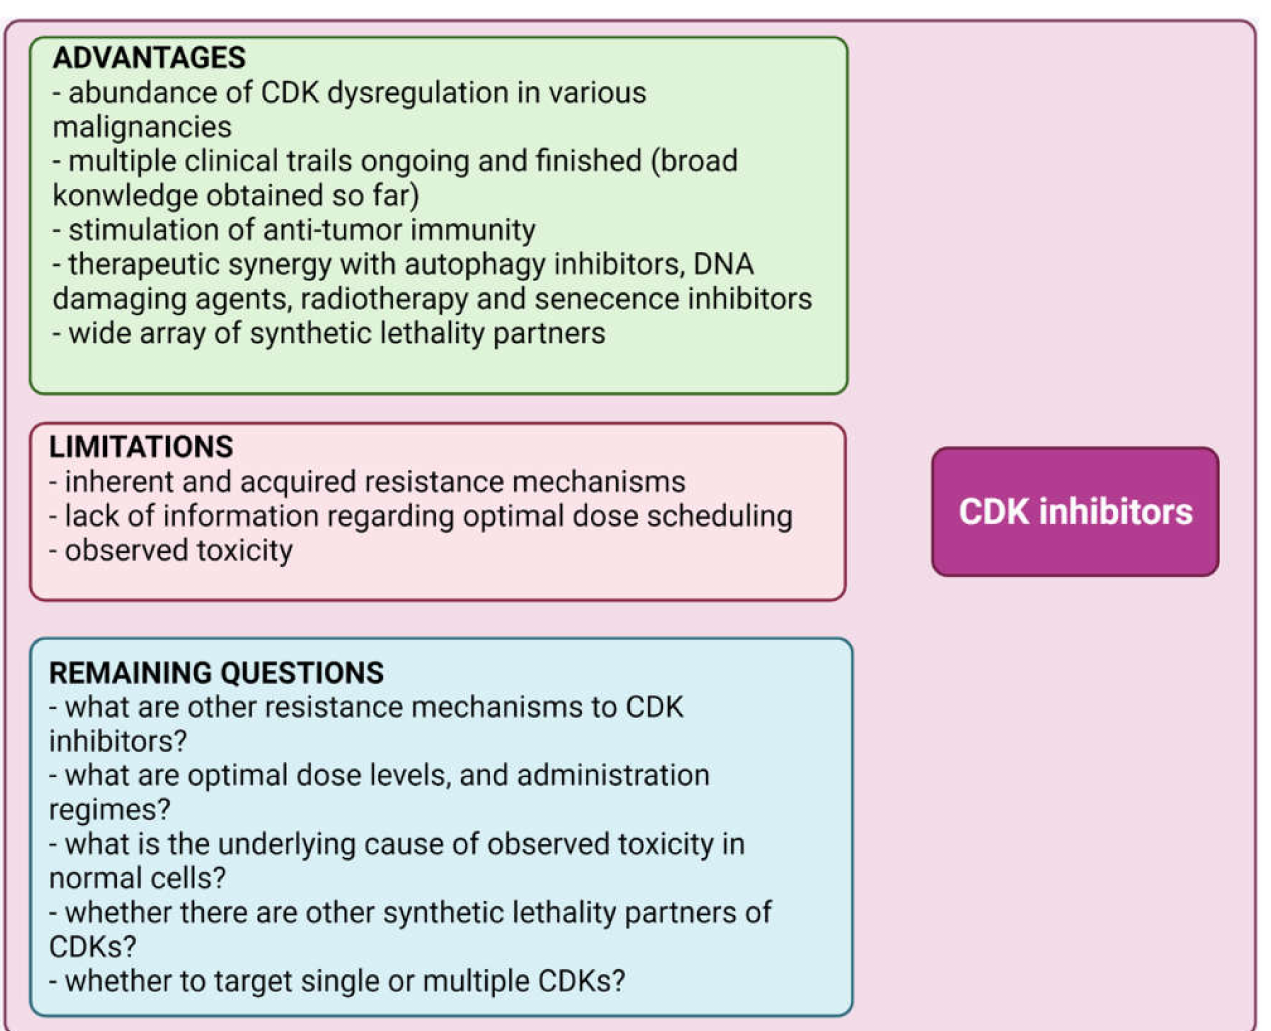
Figure 3. Advantages, limitations and remaining questions regarding use of cyclin-dependent kinase (CDK) inhibitors. Created with BioRender.com (accessed on 1 February